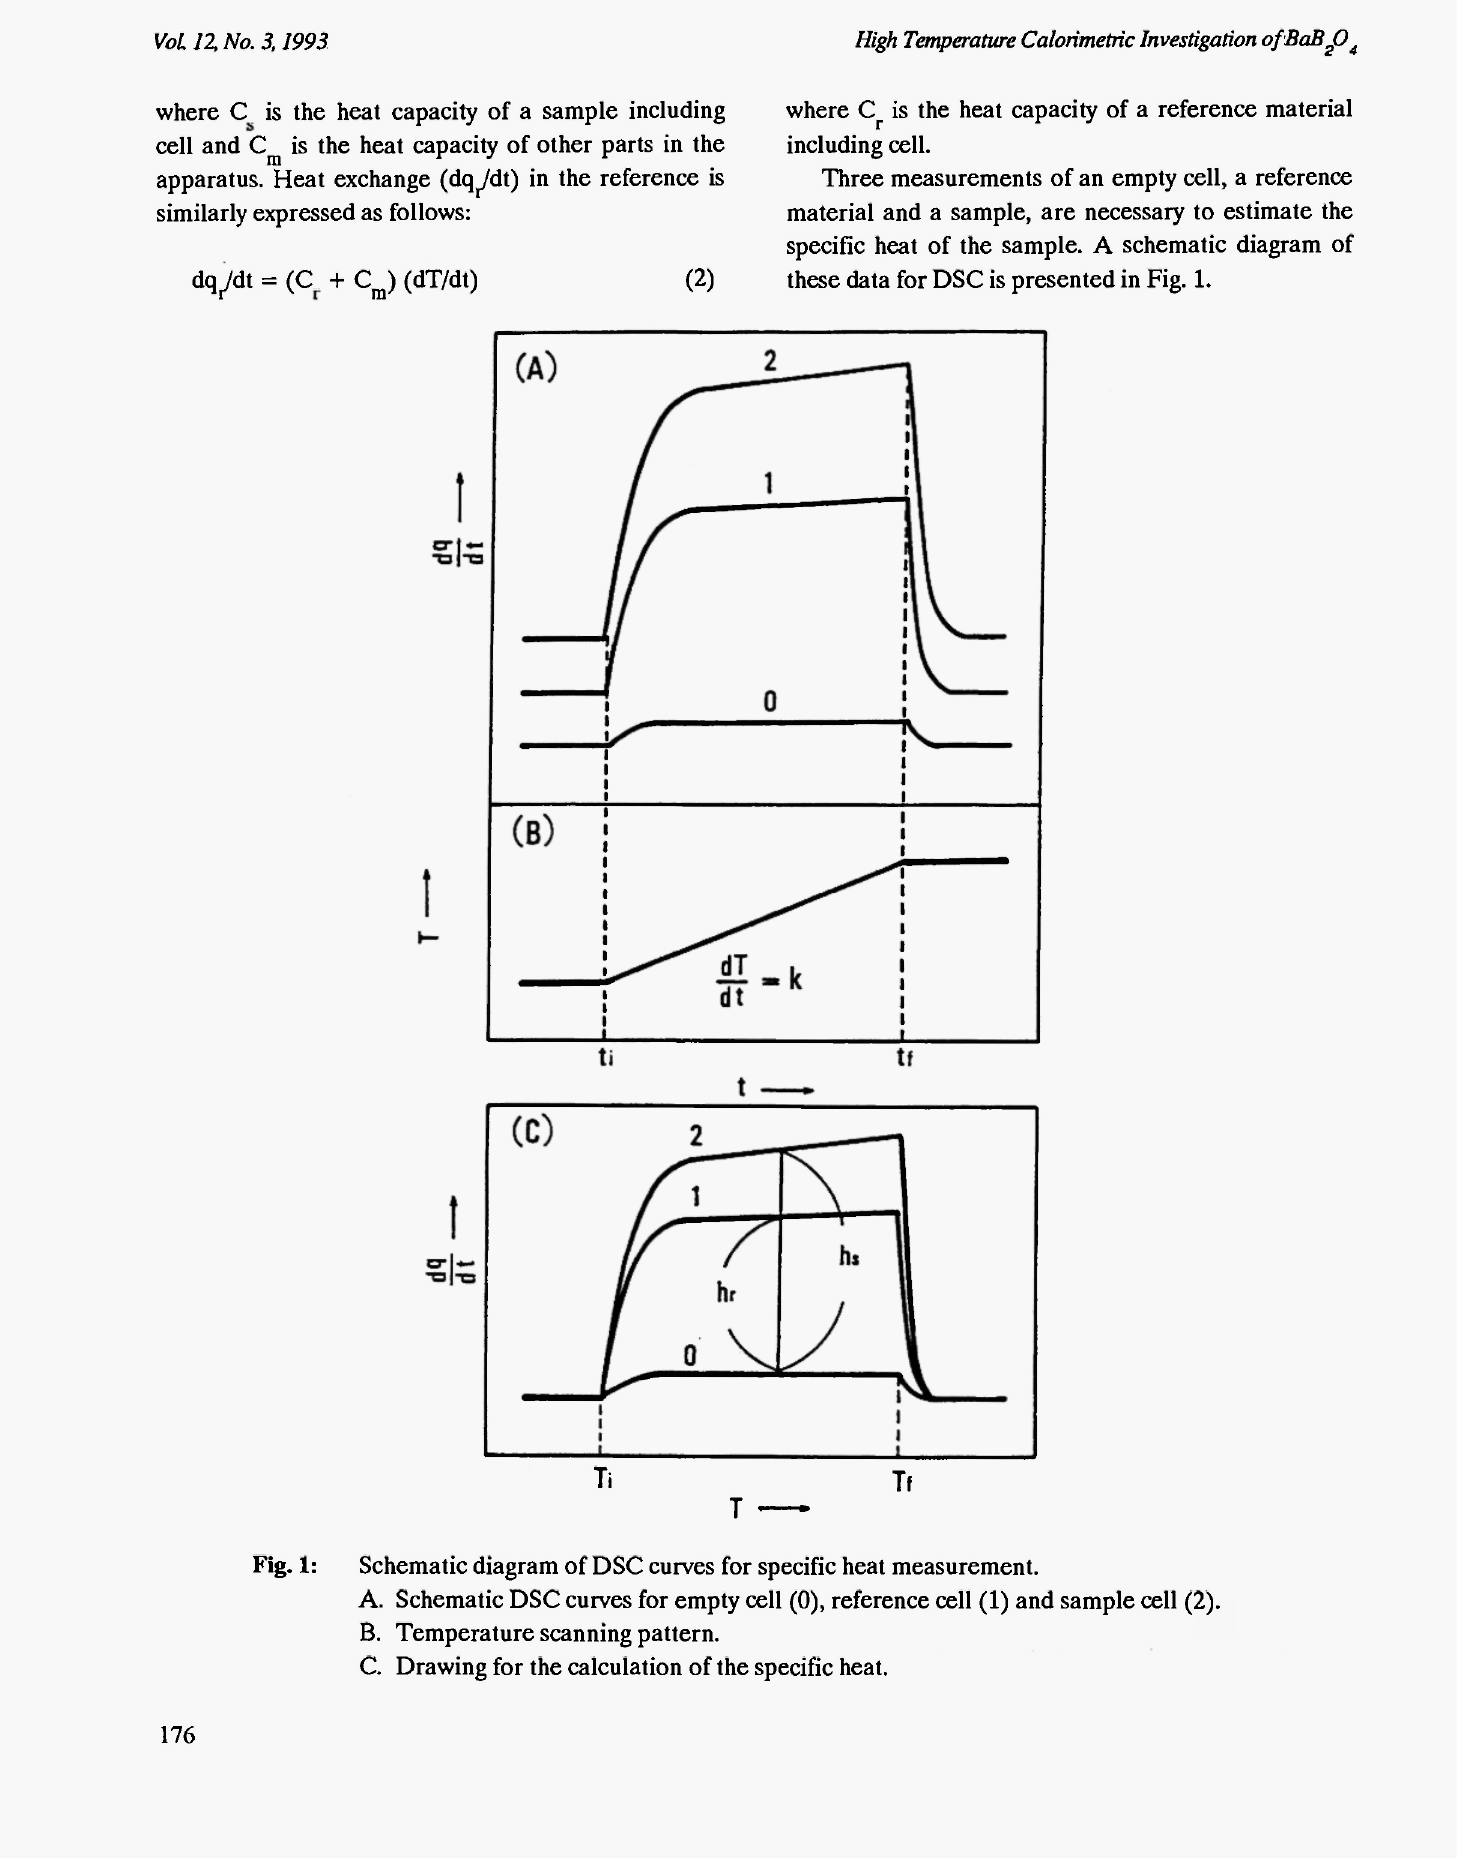
Fig. 1: Schematic diagram of DSC curves for specific heat measurement. A. Schematic DSC curves for empty cell (0), reference cell (1) and sample cell (2). B. Temperature scanning pattern. C. Drawing for the calculation of the specific heat.